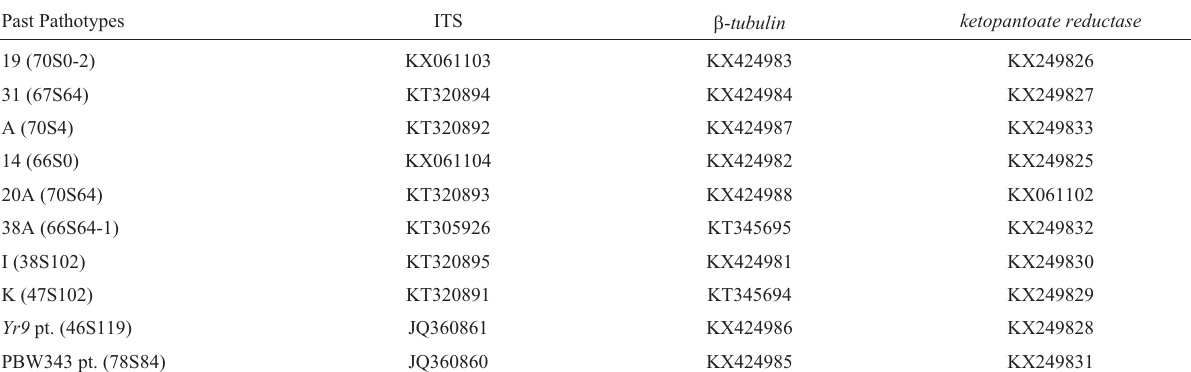
Table 2 - Indian Pst pathotype sequences of ITS and (cid:2) - tubulin and ketopantoate reductase submitted to NCBI for phylogenetic study. Past Pathotypes